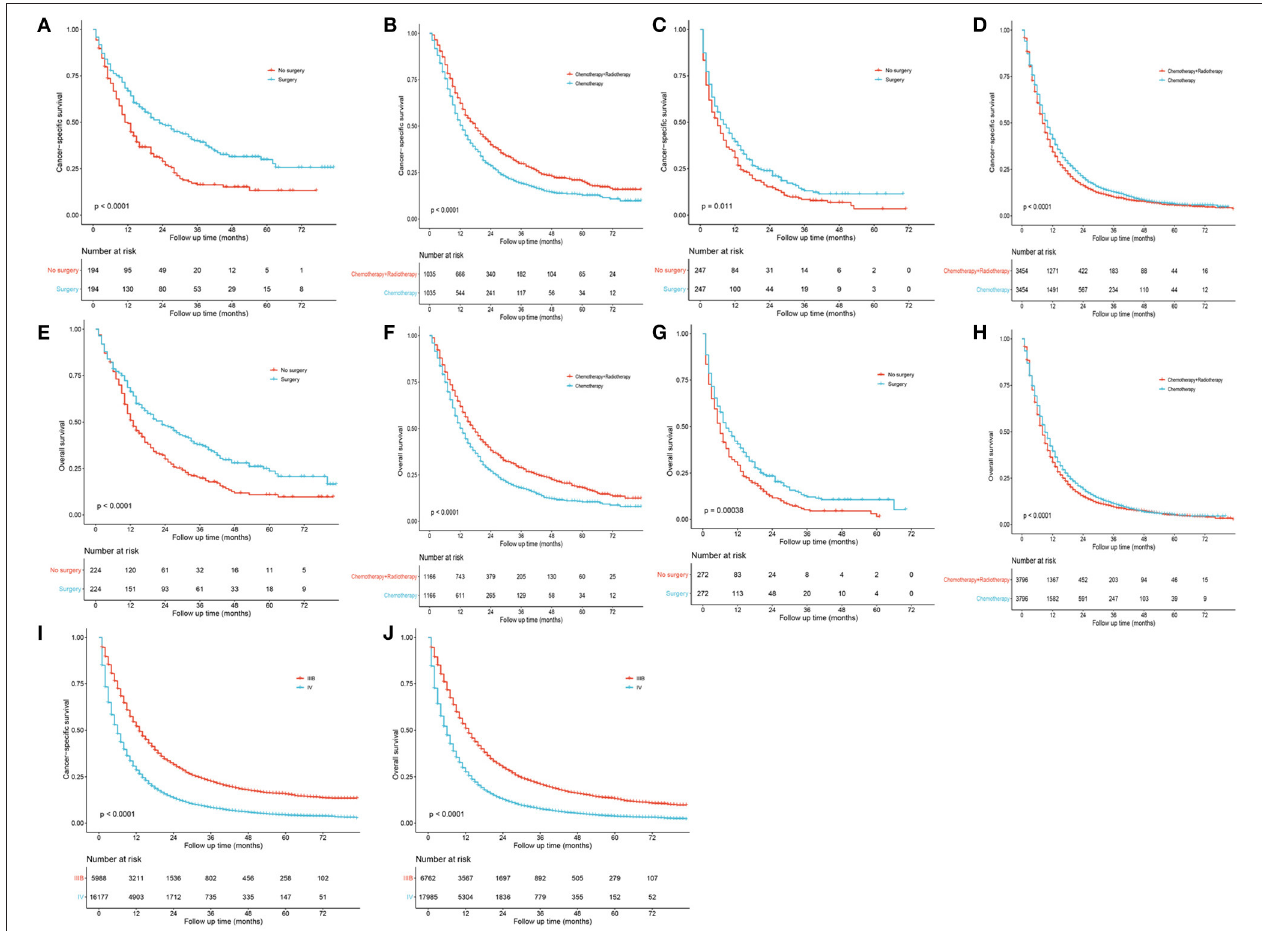
FIGURE 7 | Survival curves after propensity score matching. (A,E) Surgery vs. no surgery for IIIB patients. (B,F) Chemotherapy vs. chemotherapy plus radiotherapy for IIIB patients. (C,G) Surgery vs. no surgery for IV patients. (D,H) Chemotherapy vs. chemotherapy plus radiotherapy for IV patients. (I,J) Stage IIIB vs.